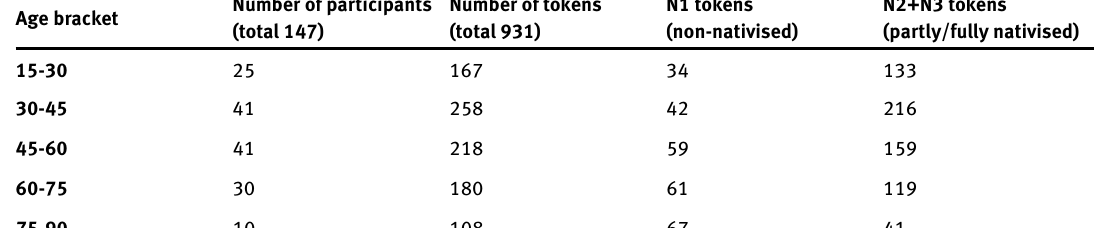
Table 5: Distribution of fingerspelling-related tokens by age band